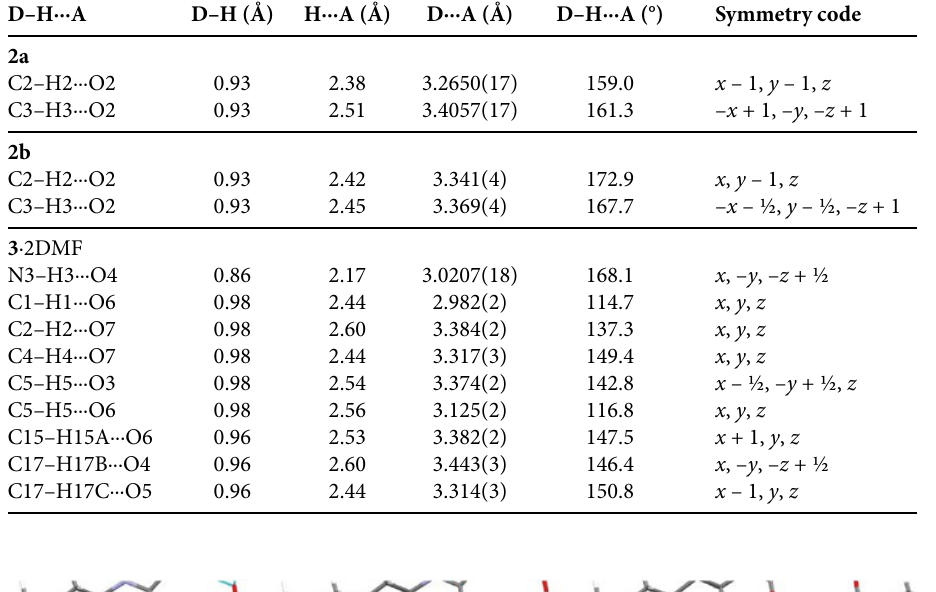
Table 2. Hydrogen bond geometry of 2a , 2b and 3 ∙2DMF (Å and °).